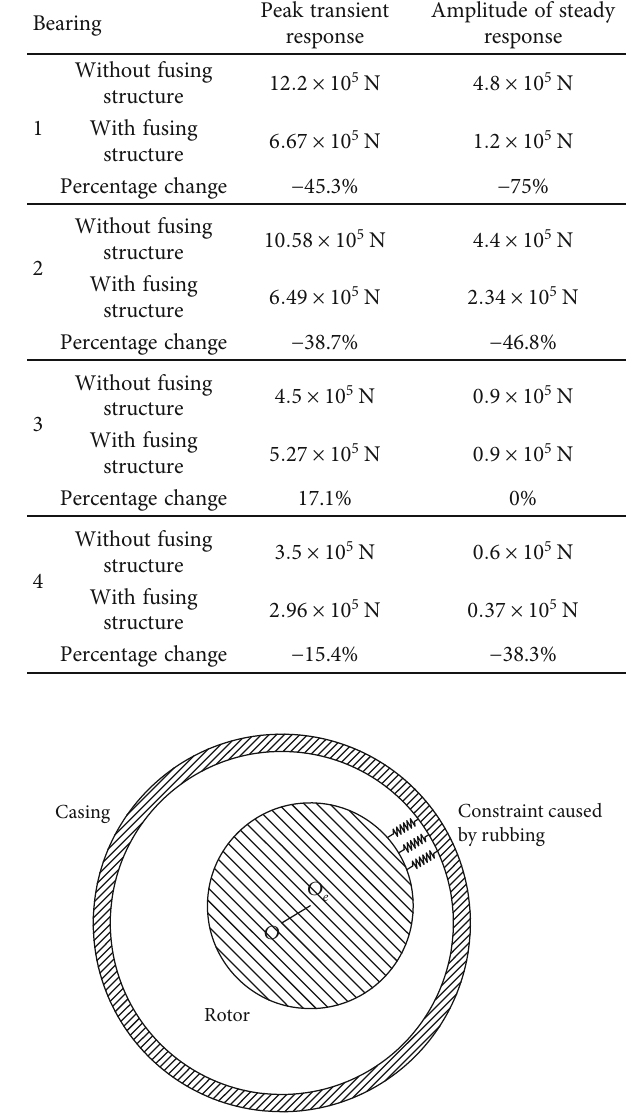
Figure 19: Model of a rotor with continuous rubbing